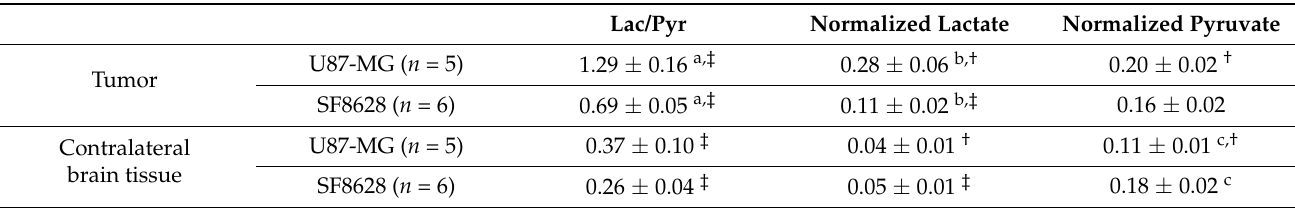
Table 1. Summary of the metabolite quantification from the two types of tumor models. U87-MG and SF8628 cell lines were used to create the intracranial models of enhancing and non-enhancing brain tumors, respectively. The values are reported as the mean ± standard error of the mean.